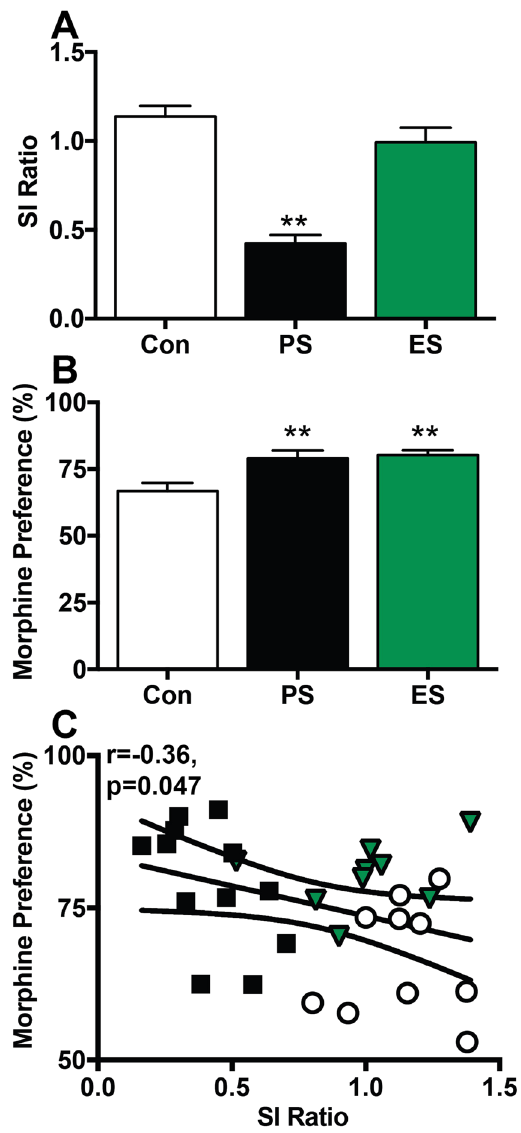
Figure 5. Increased voluntary morphine consumption immediately following CSDS. ( A ) Social interaction (SI) ratio on post-stress day 1 was significantly decreased in physical stress (PS) but not emotional stress (ES) mice. ( B ) Both PS and ES mice displayed significantly increased preference for a morphine solution compared to control mice. ( C ) Morphine preference was significantly negatively correlated with SI ratio. n = 9–12 mice/ group; ** p < 0.01 compared to control, Tukey’s post-hoc